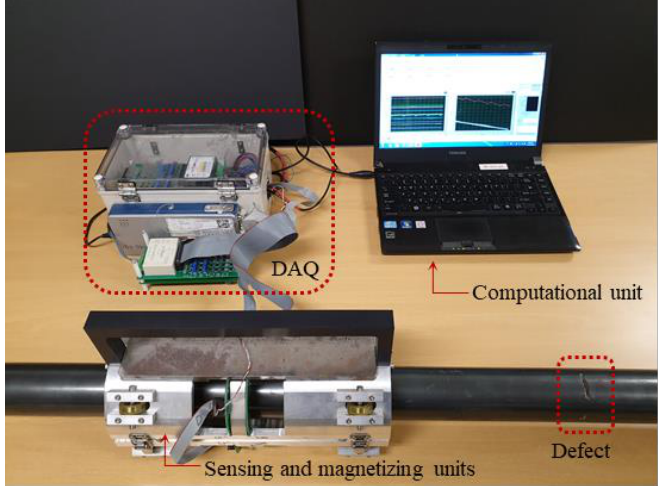
Sensors 2021 , 21 , x FOR PEER REVIEW Figure 11. Electromagnetic sensor, defected specimen, and data acquisition (DAQ) system.